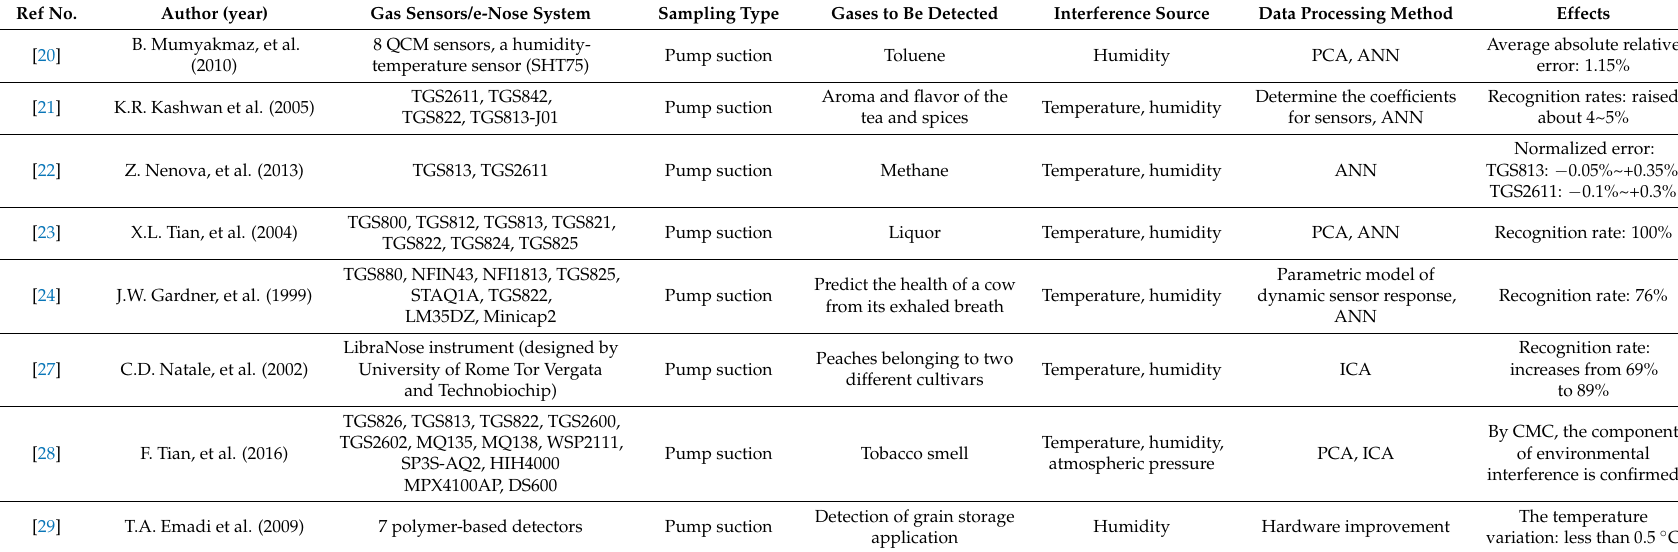
Table 1. Methods for suppressing the interferences caused by environmental